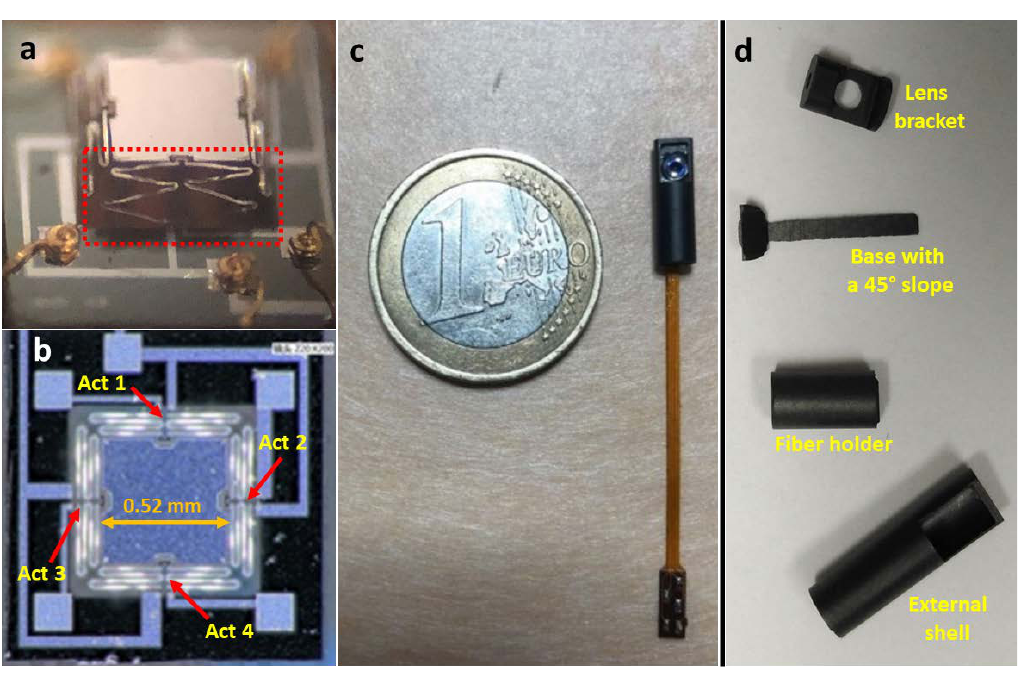
Figure 2. ( a ) An optical image of the Micro-Electro-Mechanical System (MEMS) mirror showing one of its two-level-ladder, double S-shaped actuators (red square); ( b ) Scanning electron microscopic (SEM) image showing the four actuators with the mirror plate; ( c ) Assembled probe; ( d ) Probe mechanical components.